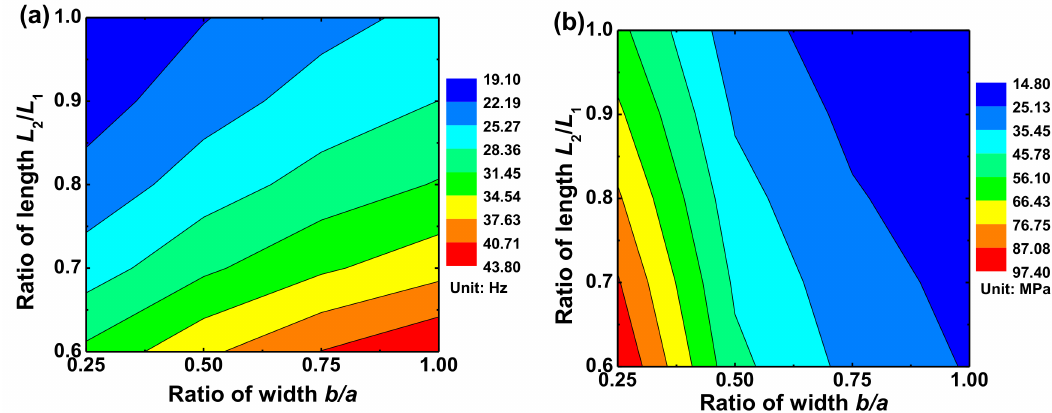
Figure 3. Calculated eigenfrequency ( a ) and maximum stress ( b ) of the basic QTOPS.